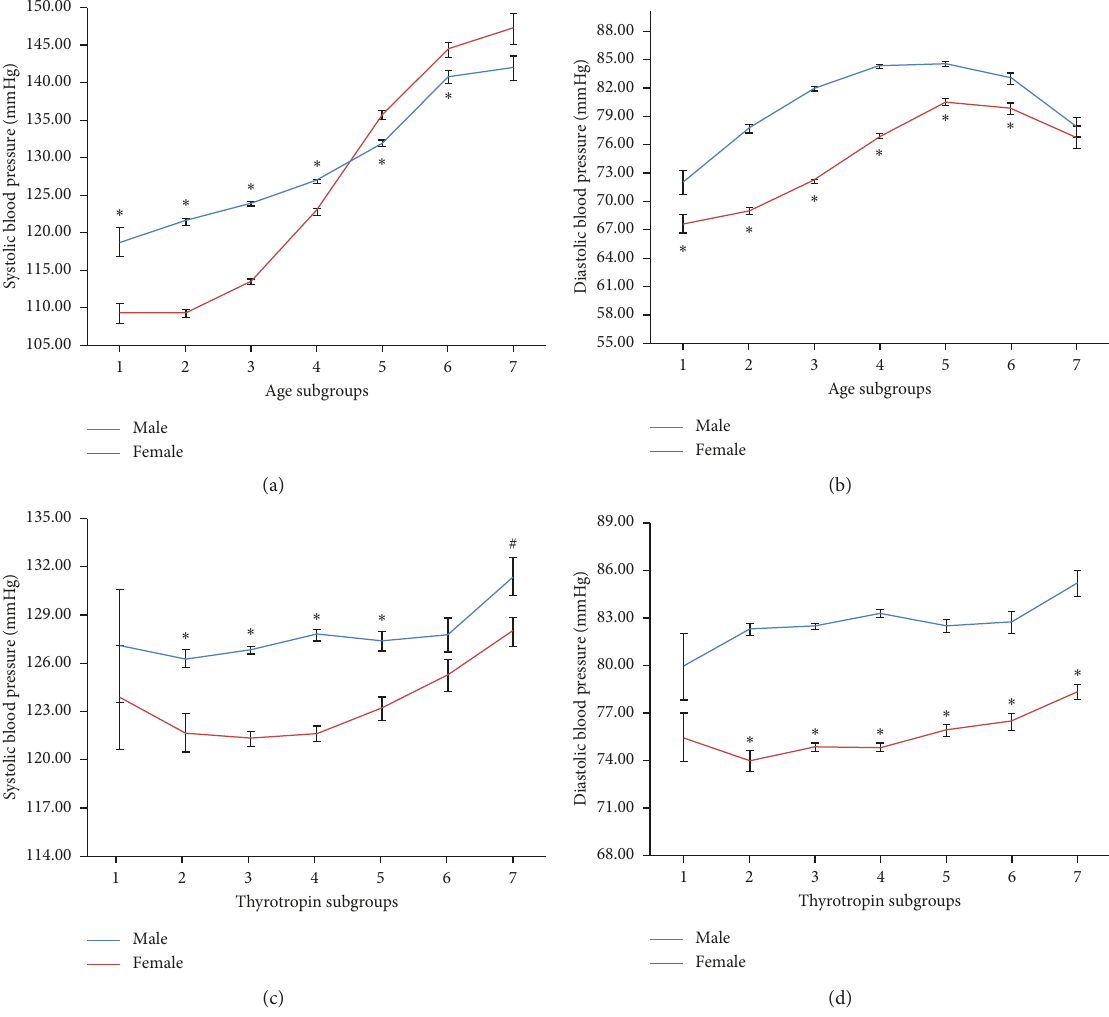
Figure 2: Systolic blood pressure and diastolic blood pressure levels in different age subgroups or different thyrotropin subgroups. (a, b) Age subgroups 1 to 7 are referred as follows: age < 25 years, 25 years ≤ age < 35 years, 35 years ≤ age < 45 years, 45 years ≤ age < 55 years, 55 years ≤ age < 65 years, 65 years < age ≤ 75 years, and age > 75 years. ∗ Difference of blood pressure levels between genders was significant at 0.01. (c, d) Thyrotropin subgroups 1 to 7 are referred as follows: TSH ≤ 0.3mIU/L, 0.3 μ lU/mL < TSH ≤ 1.0 μ lU/mL, 1.0 μ lU/ mL < TSH ≤ 2.0 μ lU/mL, 2.0 μ lU/mL < TSH ≤ 3.0 μ lU/mL, 3.0 μ lU/mL < TSH ≤ 4.0 μ lU/mL, 4.0 μ lU/mL < TSH ≤ 5.0 μ lU/mL, and TSH > 5.0mIU/L. # Difference of blood pressure levels between genders was significant at 0.05; ∗ Difference of blood pressure levels between genders was significant at